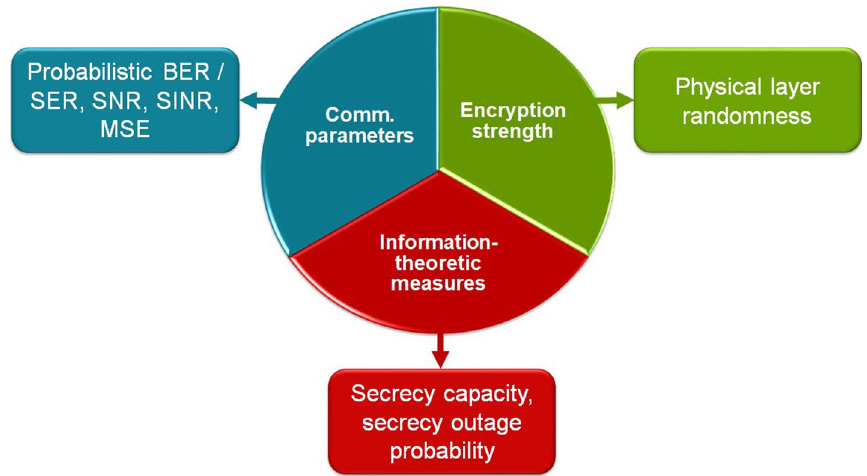
Fig. 2 Three different viewpoints (communications, information-theoretic and cryptographic encryption) from which the physical layer security of directional modulation techniques is studied are highlighted. Moreover, different parameters that are used by each approach are